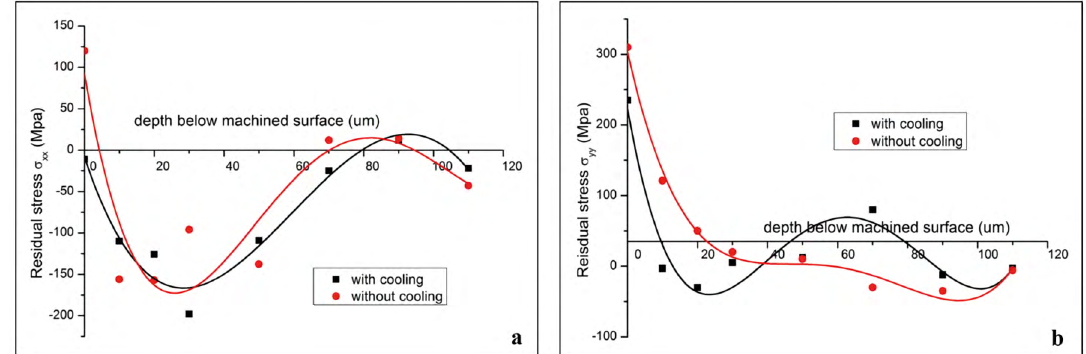
, (b) σ , ( a =0.3mm, a =0.2mm, V =60m/min, f =0.06mm/rev, xx yy p e eff